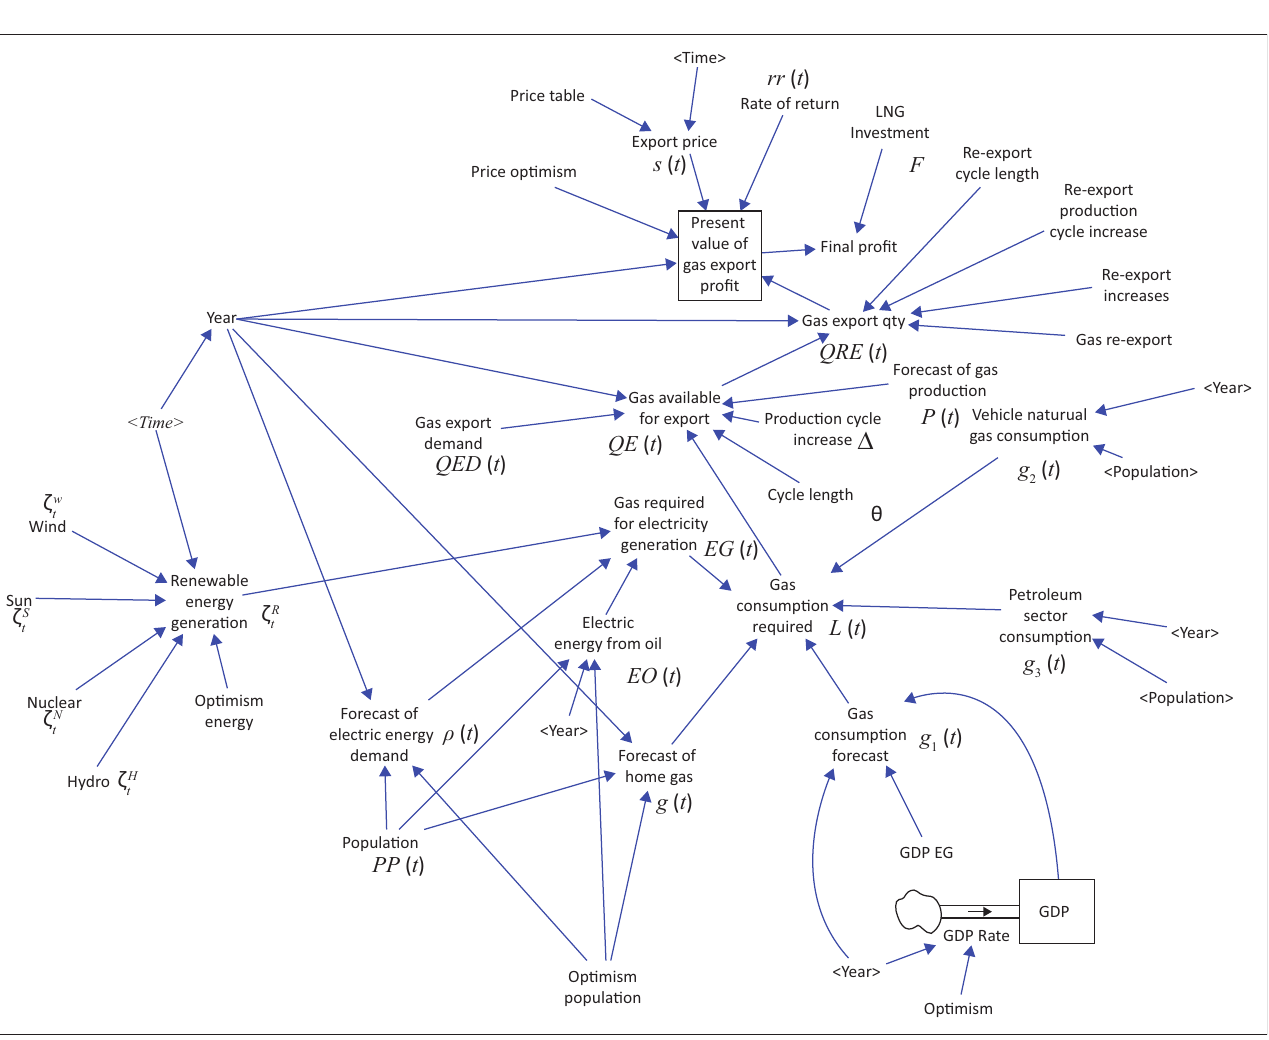
FIGURE 1: The system dynamics model of Liquefied Natural Gas Export in Egypt.